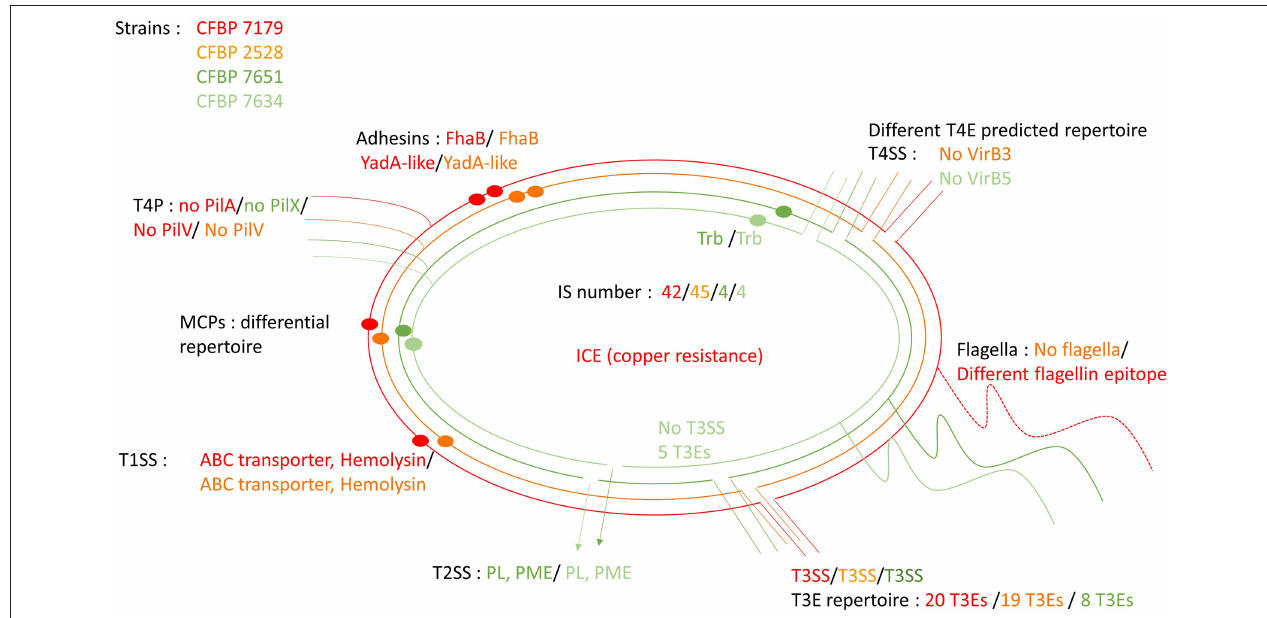
FIGURE 10 | Schematic representation highlighting conserved and differential features between the four genome sequences. Specific features are written using the color code: red for CFBP 7179; orange for CFBP 2528; dark green for CFBP 7651, light green for CFBP 7634.